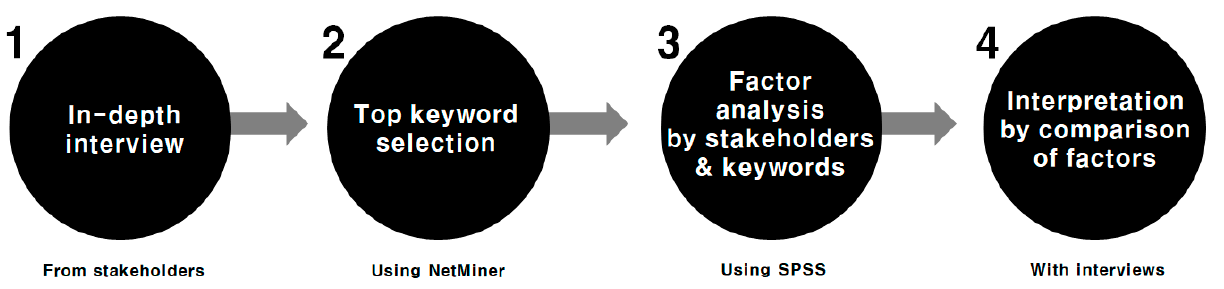
Figure 2. The text mining process.